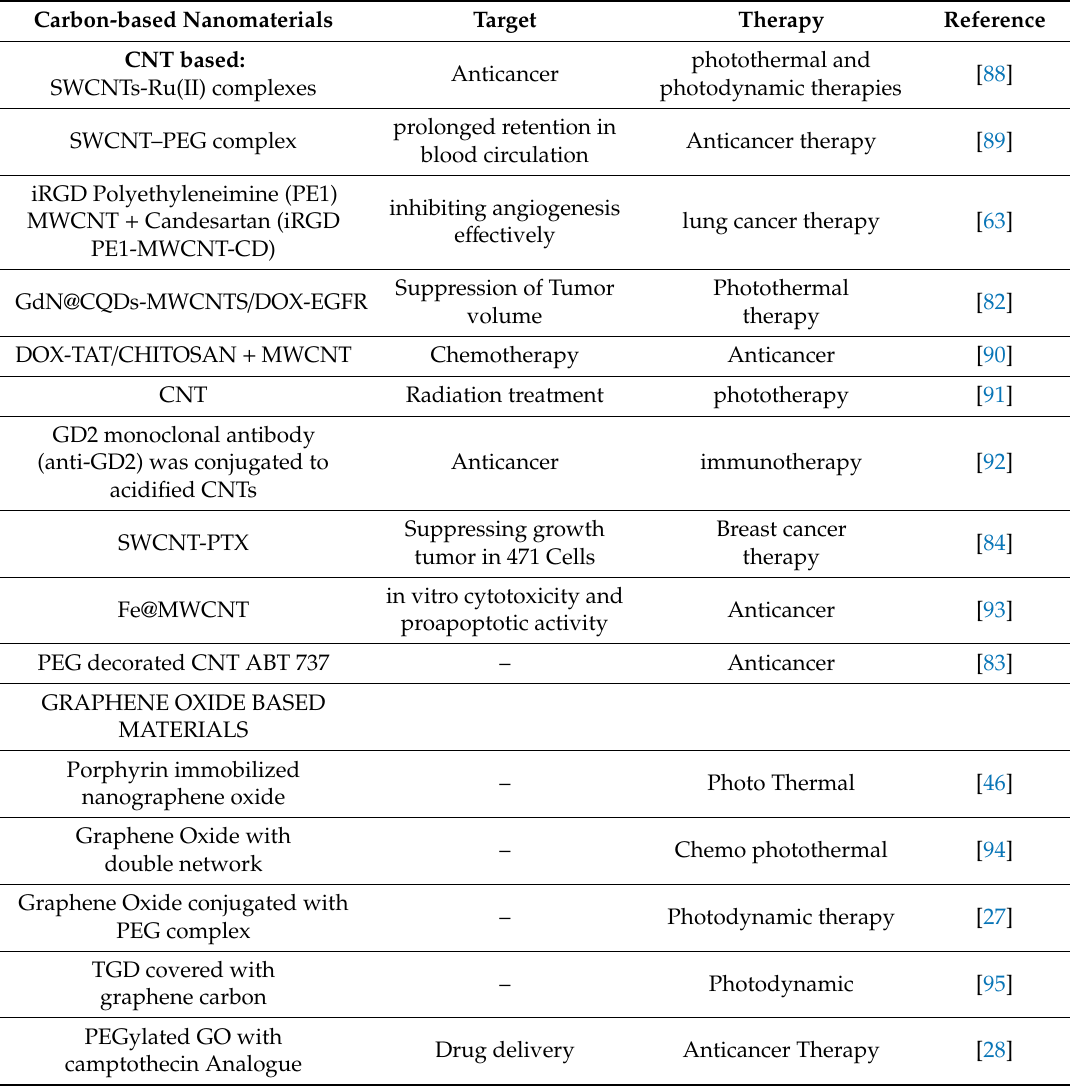
Table 1. Showing the list of recently developed carbon-based nanomaterial used in anti-cancer therapy. Carbon-based